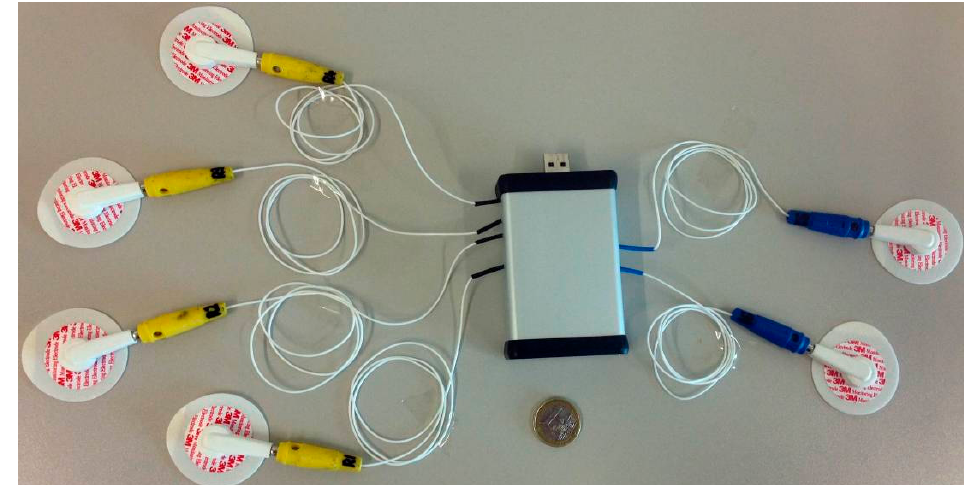
Figure 3. The realized prototype, with connectors for four sensing electrodes (yellow), two injecting electrodes (blue) and a USB port for data input/output with a personal computer; the tetrapolar electrode set-up allows using standard electrocardiographic disk electrodes.